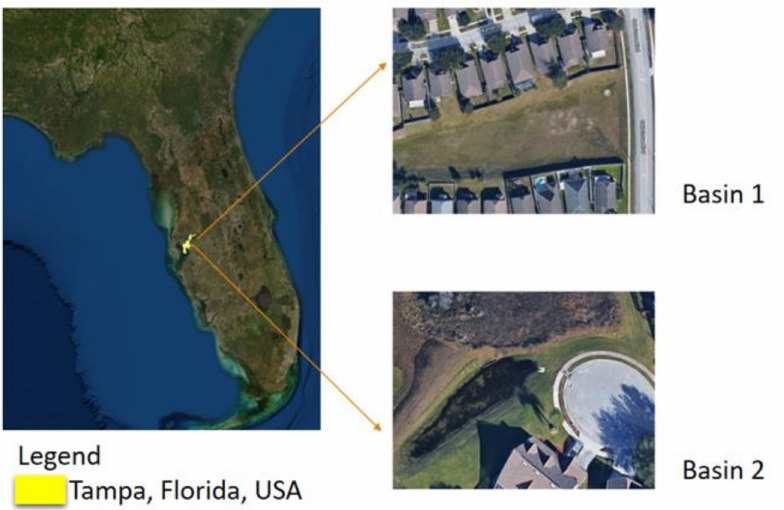
Figure 1. Map of the research site and aerial image of the research stormwater infiltration basins (SIBs) in Lutz, Florida, USA (part of the Tampa FL metropolitan